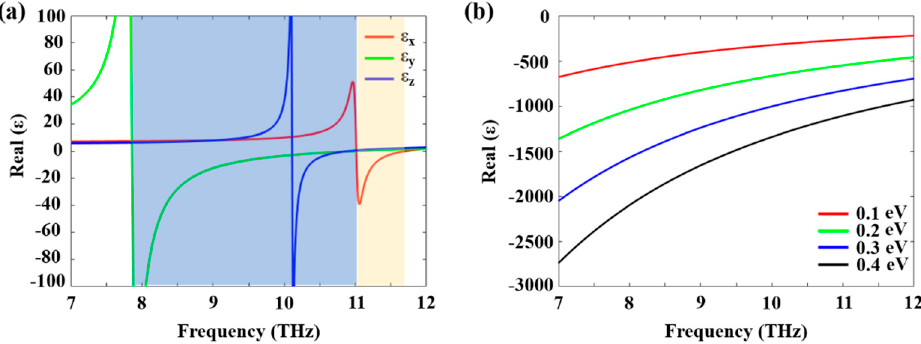
Figure 1. Dielectric permittivity of α -MoO 3 and graphene in the THz spectral range. ( a ) The real parts of the permittivity tensor of α -MoO 3 reveal two distinct in-plane RBs with negative permittivities along different crystal axes, shaded in blue and yellow RBs along [001] and [100] crystalline directions, respectively. ( b ) The real parts of graphene permittivity with different Fermi energies.